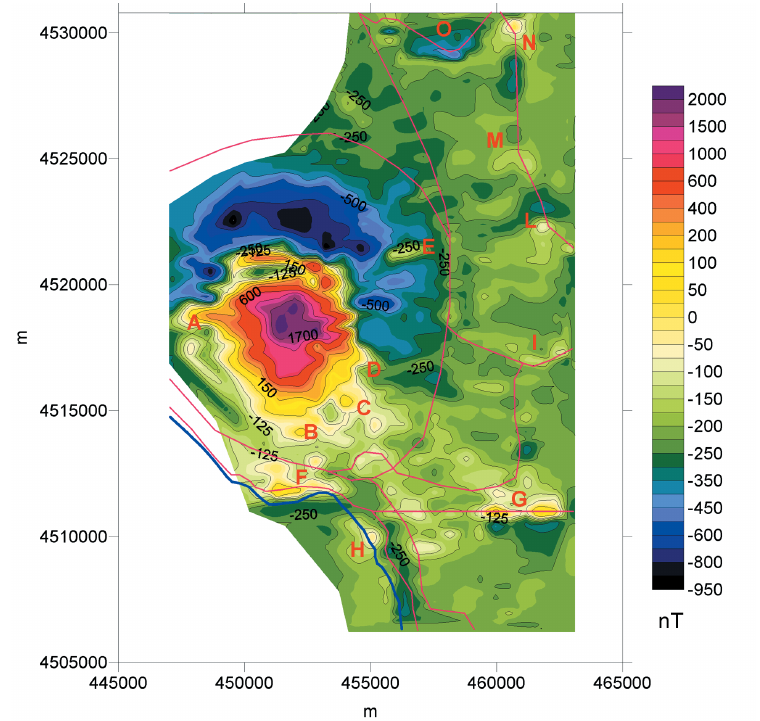
Fig. 2. The new magnetic map of the Vesuvian area obtained from the aeromagnetic survey performed in Oc- tober 1999. The red lines show the railway lines, the blue line shows the coastline. For location of the anomalies see fig.